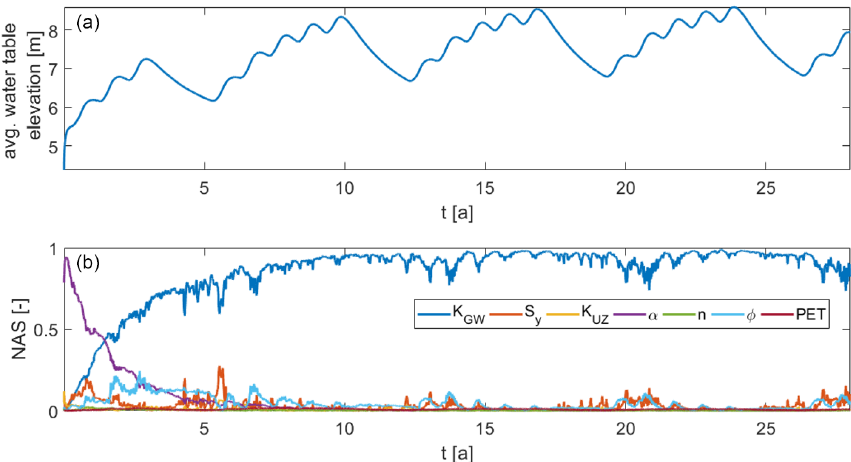
Figure 16. (a) Averaged water table elevation. (b) Transient normalized activity